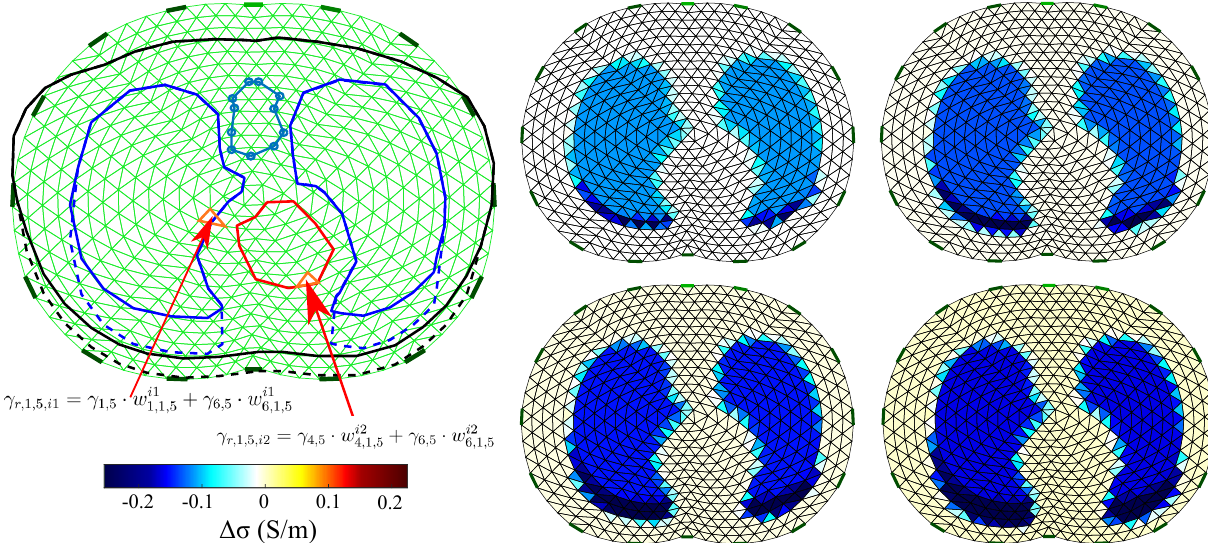
Figure 7. Visual example of the reference images’ extraction for the 1st thoracic case ( k = 1). Left : example of the absolute admittance extraction of the i 1 th and i 2 th elements when in an inflated case ( l = 5). Right : the difference image reference frames for case k = 1 when F.E.M. is applied. Only the conductivity difference (real values) is expressed in the